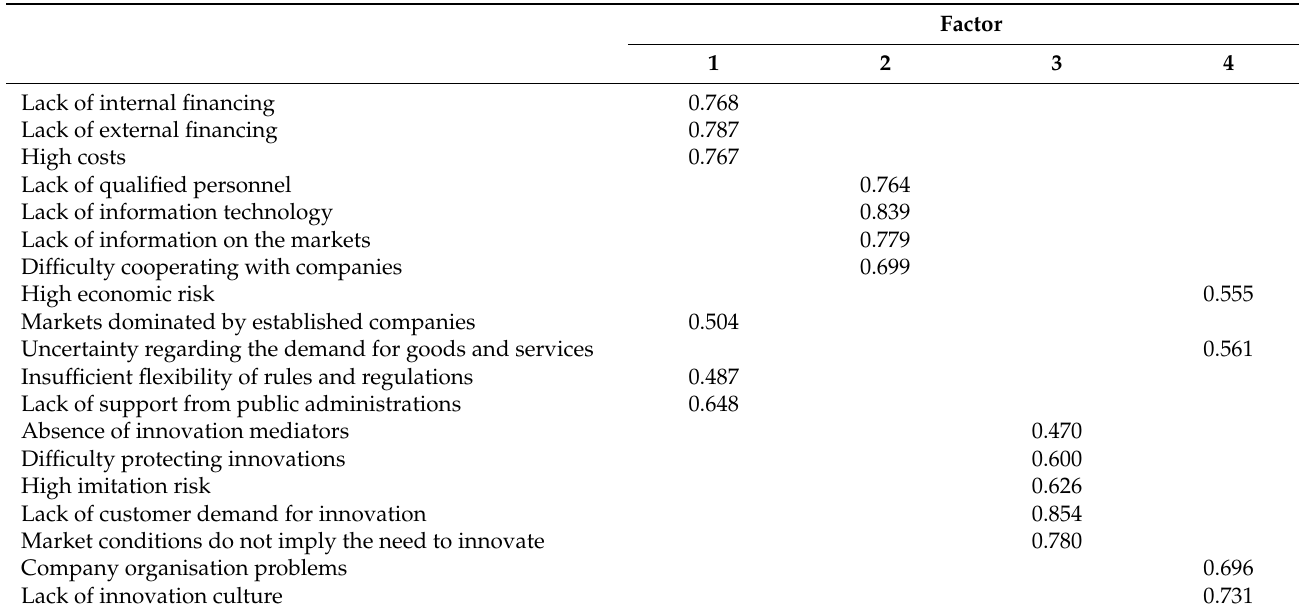
Table 7. Matrix of rotated components: barriers to